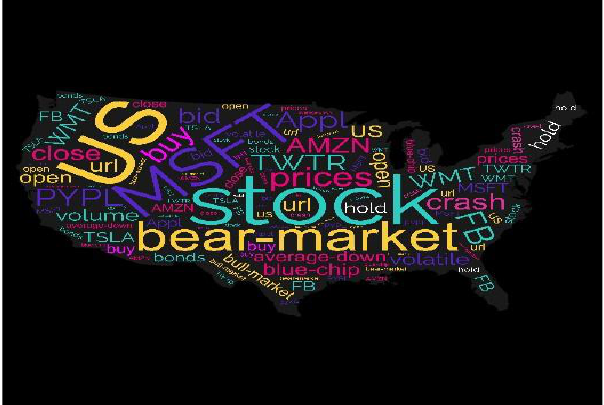
Figure 2. Word cloud diagram of stock words.